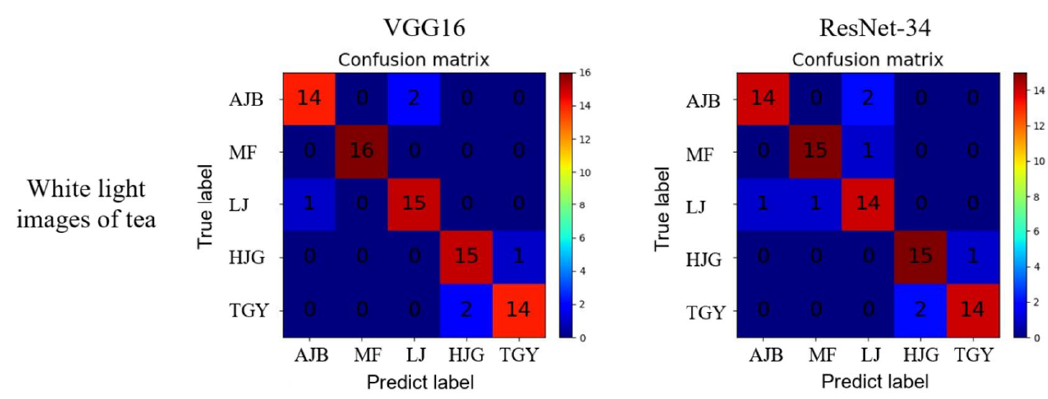
Figure 8. Confusion matrix of white ‐ light RGB images of tea.